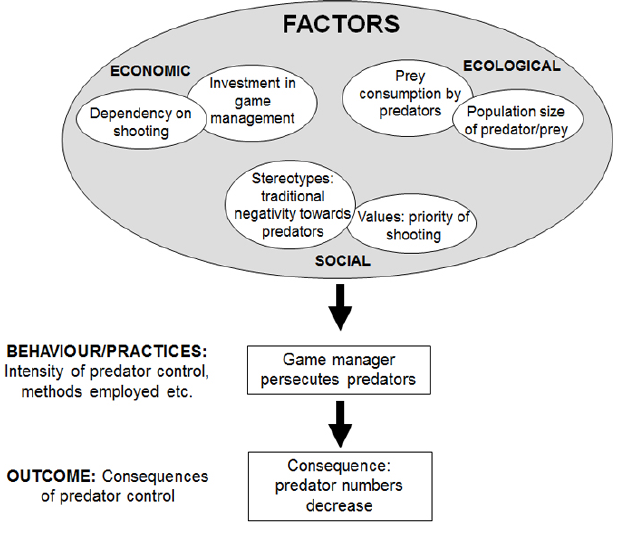
Fig. 1 . The diagram shows examples of ecological, economic and social factors relevant to the conflict between human and predators in the Iberian Peninsula (inspired by White et al. 2009), and their influence in the practices carried out by game managers. Note that the actors’ behaviour as well as the consequences are extreme